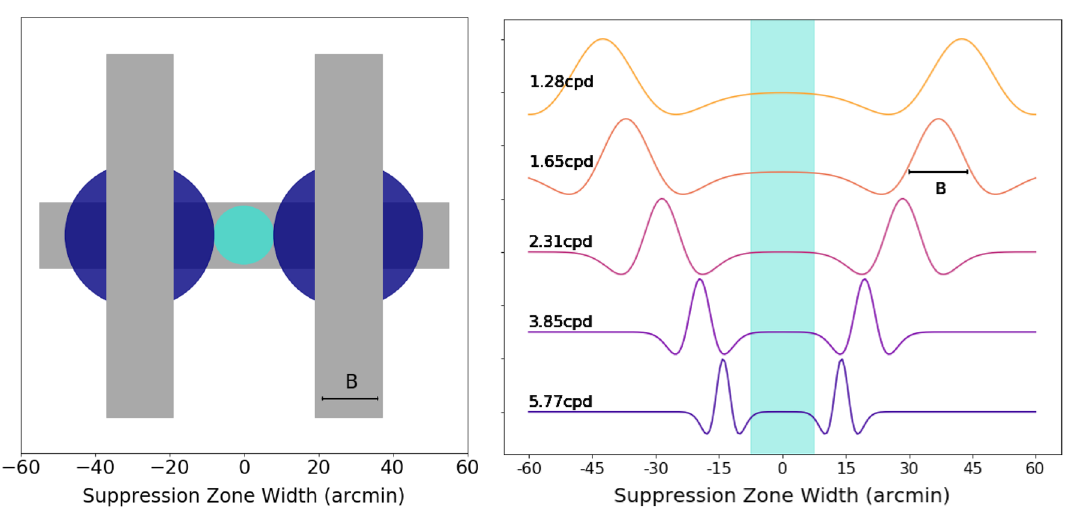
Figure 7. (Left panel) Illustration of the postulated suppression zone. The two vertical bars represent the suppressors while the horizontal bar represents the reference. Surrounding the suppressor, the area in dark blue represents the area of suppression which is stimulus-dependent, p. In between the dark blue areas, the cyan patch corresponds to the non-stimulus dependent component, delta (edge-to-edge separation, ES), where subjects were asked to fixate during the experiment. (Right panel) Illustration of the edge-to-edge separation at different spatial frequencies. The ES is scale invariant, as indicated in the shaded cyan region. We only include a few spatial frequencies for illustration purposes. B is the width of the center part of the